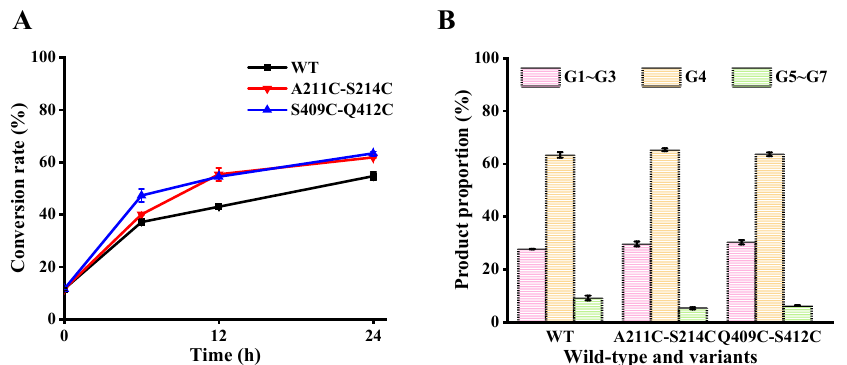
Figure 6. Hydrolysis product analysis of maltodextrin (DE = 7~9) by wild-type and mutants at 50 °C. ( A ) Conversion rate. ( B ) Product proportion of wild-type MFA ps or mutant hydrolyzed maltodextrin (DE = 7~9) for 24 h. The product proportion represents the mass ratio of the individual oligosaccharide to the total mass of G1 through G7. The conversion rate represents the ratio of the total mass of G1 through G7 to the original dry mass of the substrate. WT: wild-type MFA ps . G1~G3, glucose, maltose and maltotriose; G4, maltotetraose; G5~G7, maltopentaose, maltohexaose and maltoheptaose.